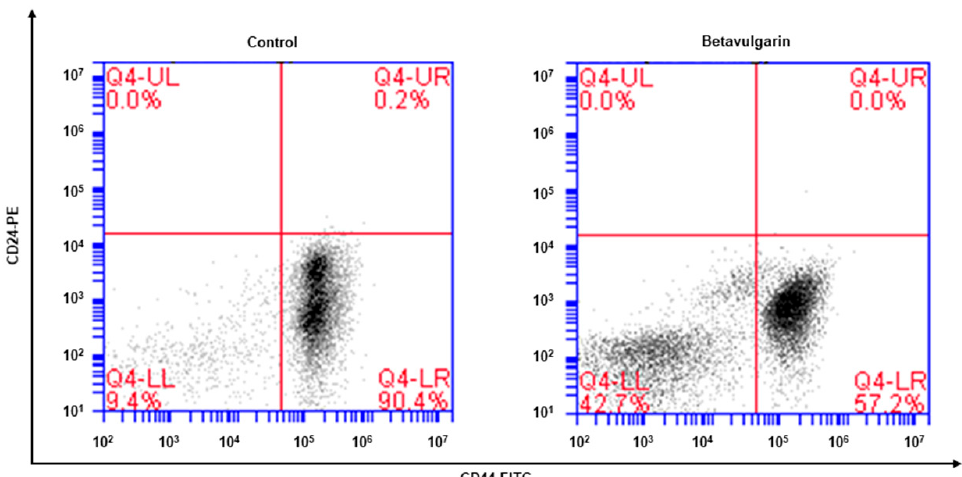
Figure 4. E ff ect of betavulgarin on the proportion of CD44 high / CD24 low cells. The CD44 high / CD24 low cell population of MDA-MB-231 cells treated with betavulgarin (200 µ M) or DMSO for 24 h was